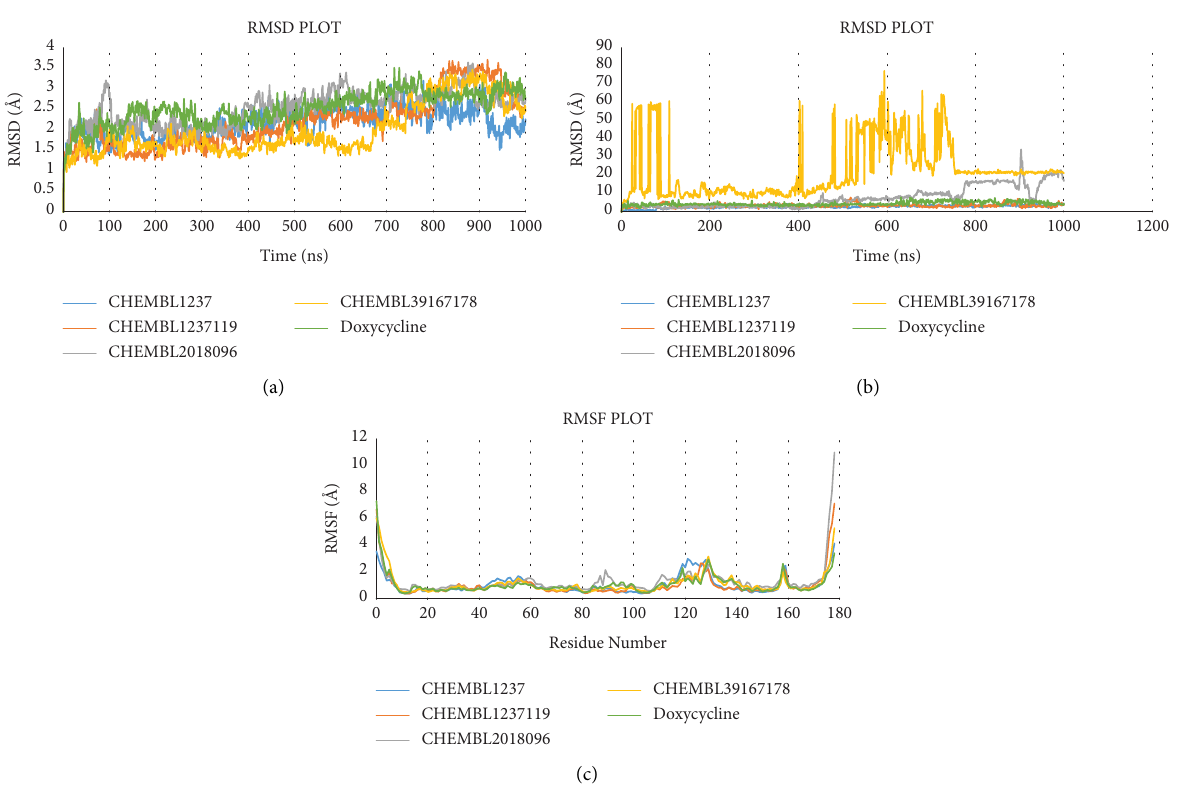
Figure 6: Graphical presentation of simulation curves. Te plots represent features of (a, b) root mean square deviation (RMSD) and (c) root mean square fuctuation (RMSF), at 100nanoseconds of molecular dynamics simulation using Desmond